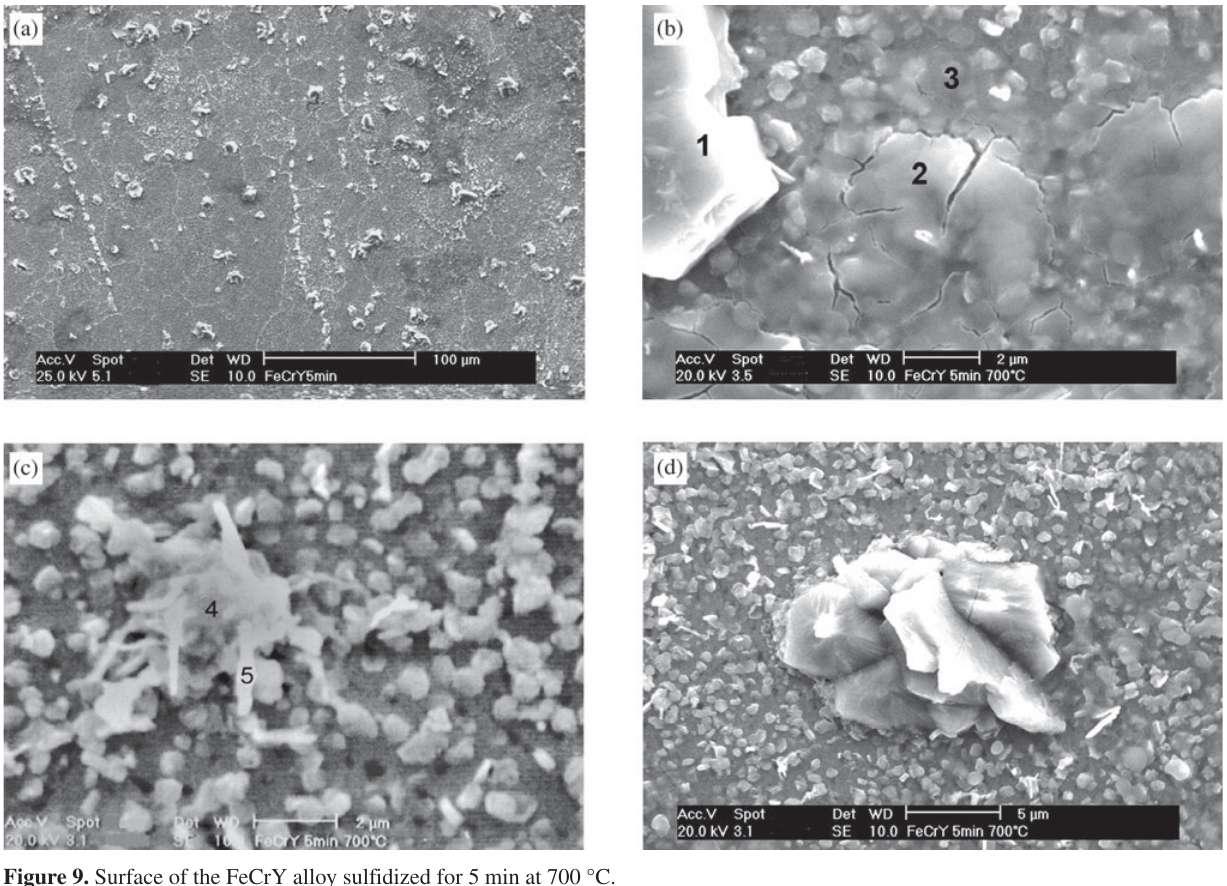
Figure 9. Surface of the FeCrY alloy sulfidized for 5 min at 700